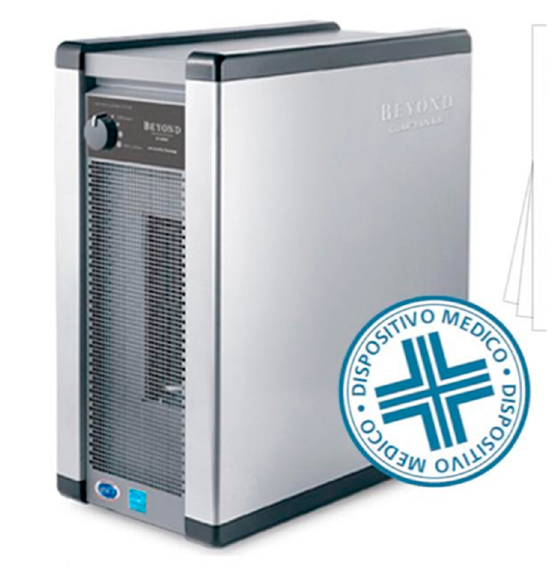
Figure 10. The sanitising system created by Nasa (https://www.activepure.com/italy-home/, https://beyond.vithagroup.eu/) .